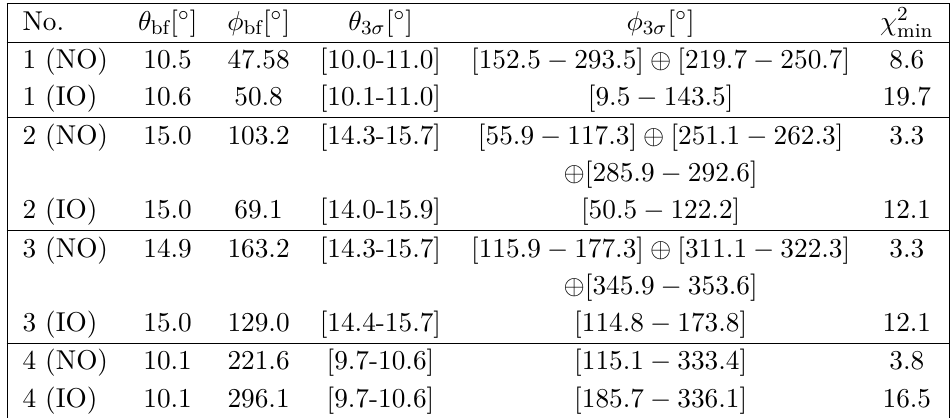
Table 2 . Overview of the ranges of the model parameters for all sum rules. For some sum rules there are multiple disjoint 3 σ regions for φ . We also include the minimal value of the χ 2 in these models. In IO the minimal χ 2 without sum rules is 10.8 whereas it is zero in